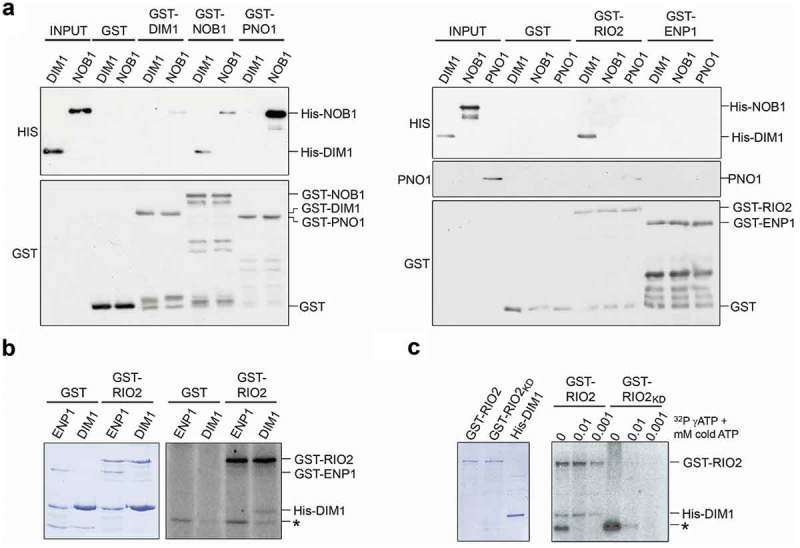
Identification of direct interactions between late-acting 18S maturation factors. A) Recombinant GST-tagged DIM1, NOB1, PNO1, RIO2 or ENP1, or the GST-tag alone, were incubated with His-tagged DIM1 or NOB1, or untagged PNO1 and complexes formed were retrieved on glutathione sepharose. Protein inputs (10%) and eluates were separated by SDS-PAGE, and bait and co-precipitated proteins were detected by western blotting using the antibodies indicated to the left of each panel. The bands corresponding to each full length recombinant protein are indicated to the right of each panel. B) His-DIM1 or GST-ENP1 were incubated with GST-RIO2 or GST in the presence of γ[32P]-labelled ATP and 0.001 mM cold ATP. C) His-DIM1 was incubated with either GST-RIO2, or GST-RIO2KD, with γ[32P]-labelled ATP and varying concentrations of cold ATP (indicated above each lane). Proteins in panels (B) and (C) were separated by SDS-PAGE, alongside non-labelled protein inputs, and detected by Coomassie staining or using a phosphorimager, respectively. The bands corresponding to the input proteins are marked on the right and a non-specific phosphorylated protein (~30 kDa) is indicated by an asterisk.